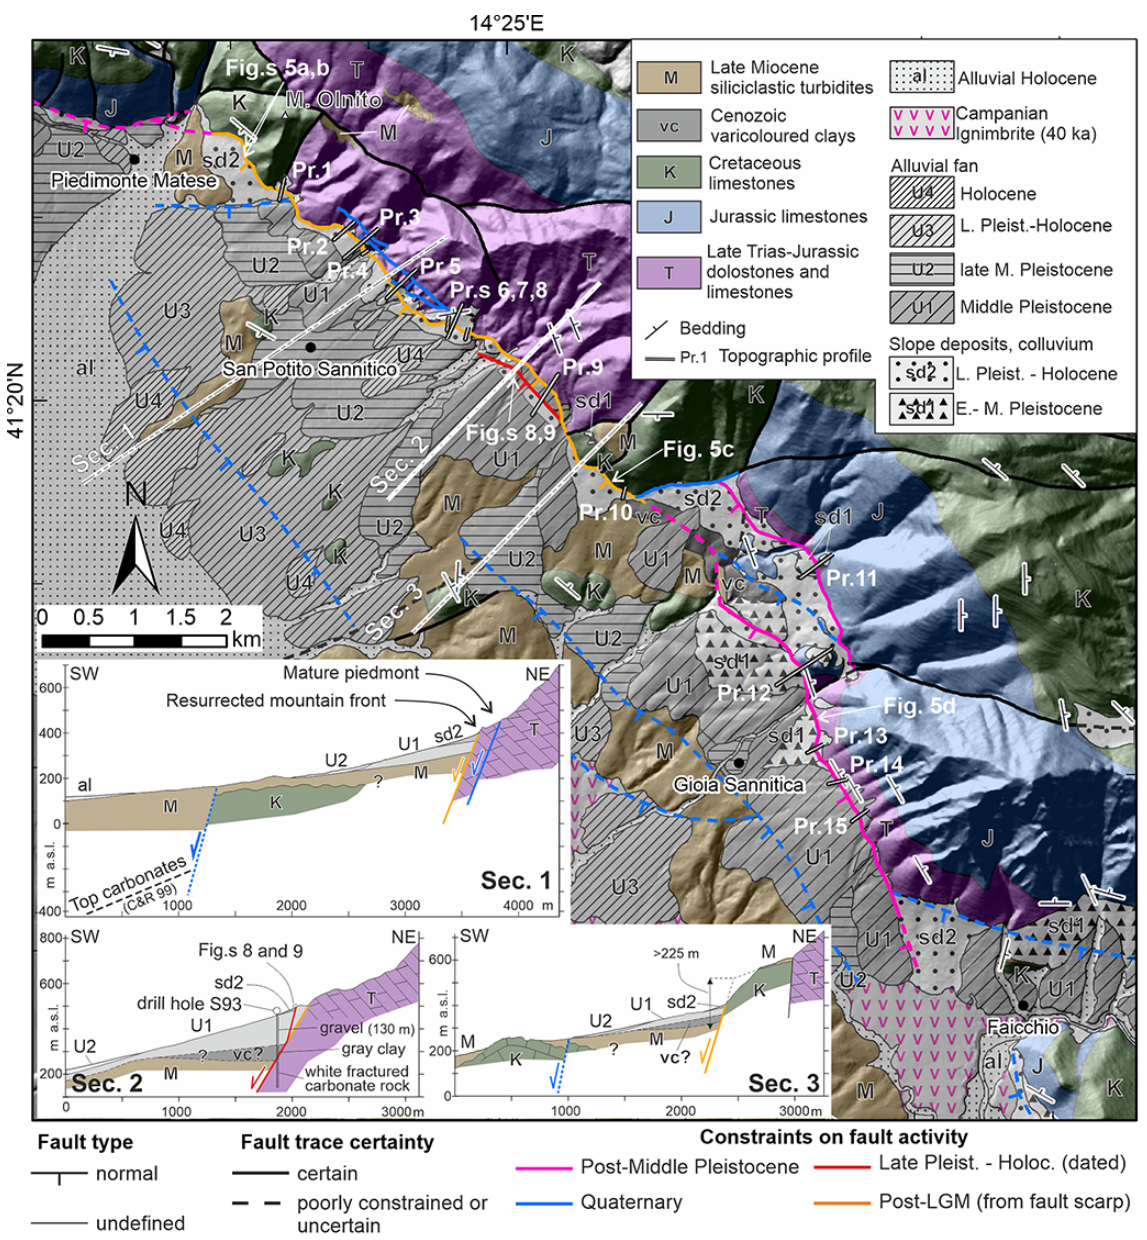
Figure 4. Geologic map of the Gioia Sannitica normal fault (additional details and cross sections in Plate S1). In Sect. 1 of this figure, C&R 99 stands for Corniello and Russo (1999). Fault traces are represented with different colours indicating different age constraints on fault activity derived from all the data collected in this work (discussed in the dedicated Sect.